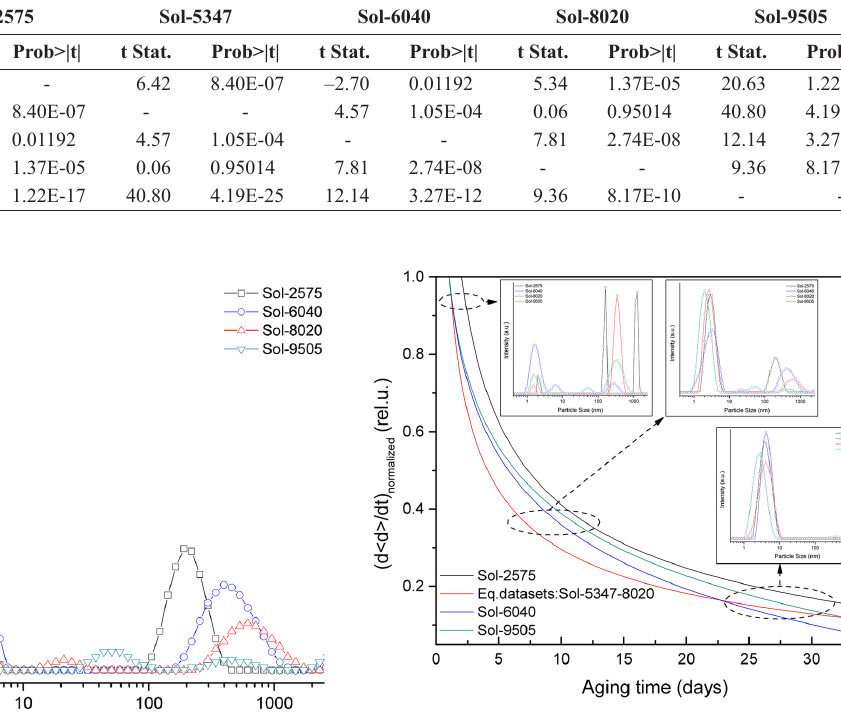
Figure 5. Another view of the aggregation kinetics according to the time evolution of the normalized aggregation velocities. The insets feature typical distribution behaviors that were mentioned and described earlier in this